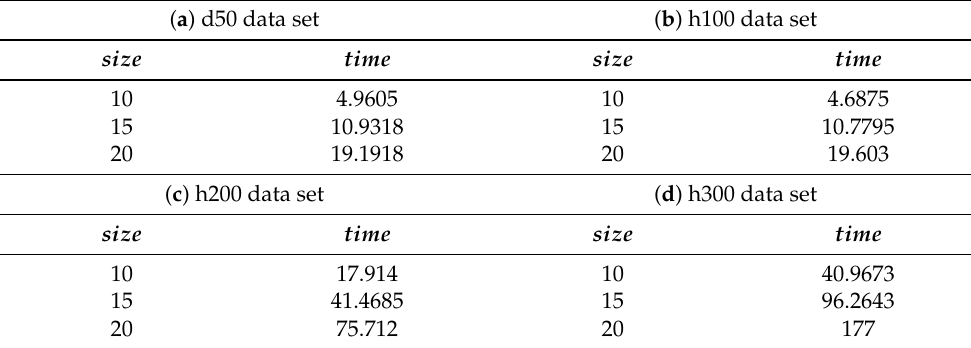
Table 5. Average pre-processing time in seconds depending on the size of the data set in the case of affine gap